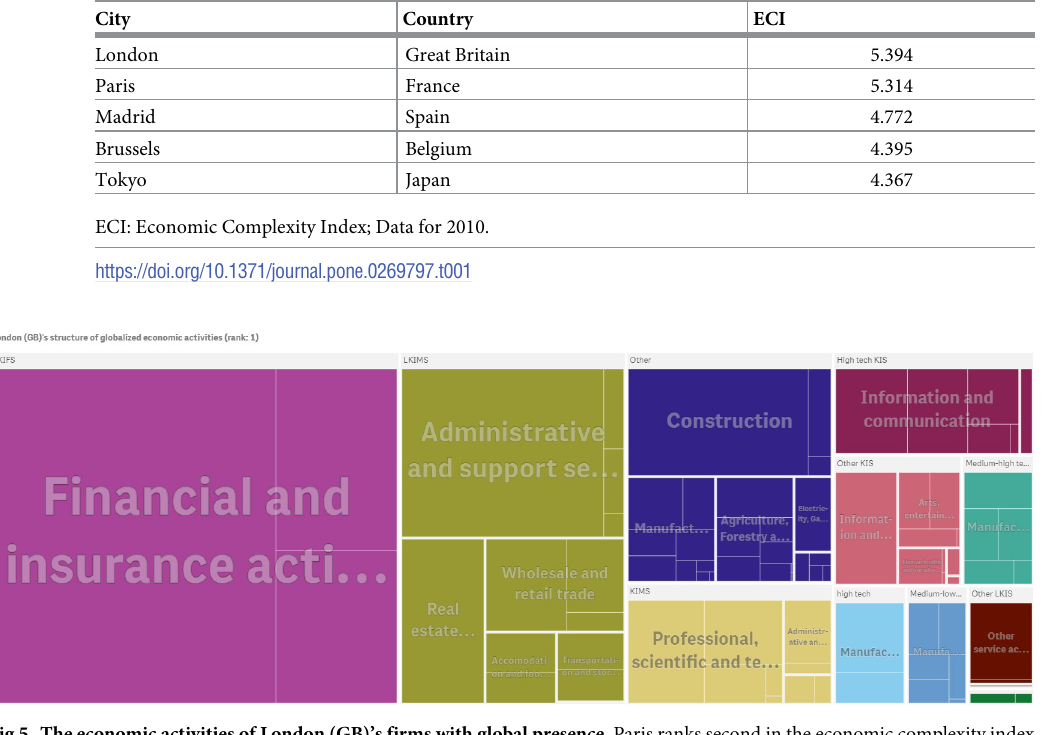
Table 1. List of the top five cities with the highest ECI values.